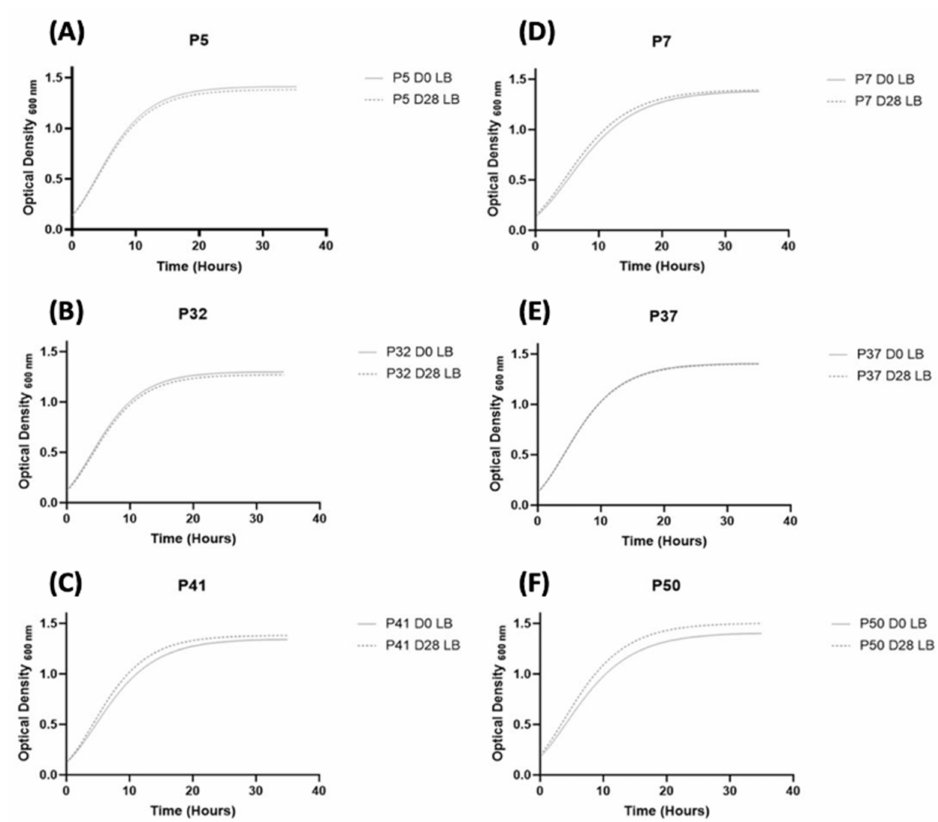
Figure 1. Growth curves of S. aureus strains using the Gompertz equation. P5 ( A ), P32 ( B ), P41 ( C ) belong to the wounds with an improving evolution. P7 ( D ), P37 ( E ), P50 ( F ) belong to the worsening wounds.